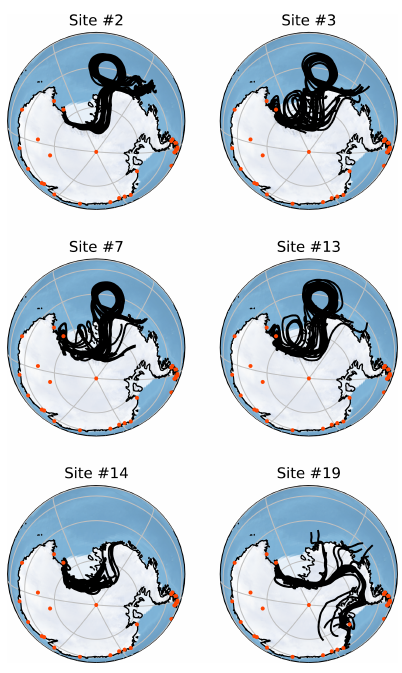
Figure A1. Like Fig. 5 but trajectories were initialized with a start- ing height of 500m.